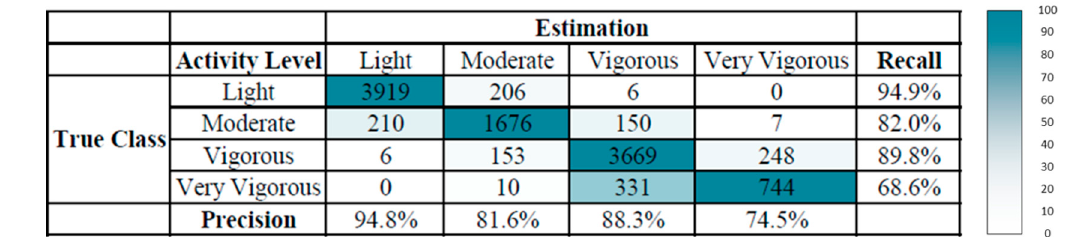
Figure 7. Confusion matrix of activity level estimation for walking, fast walking, and running tasks.